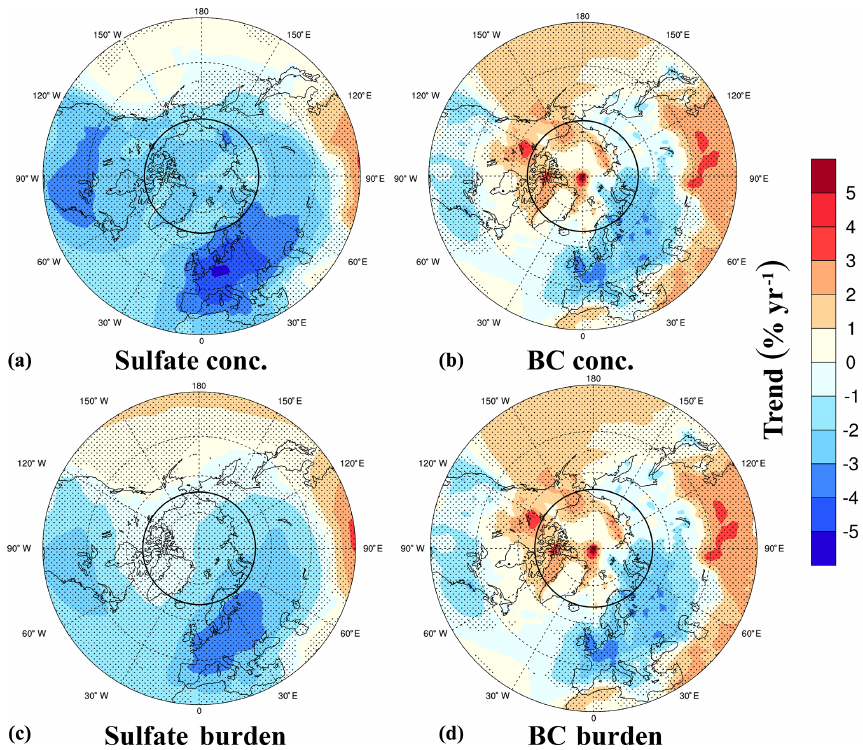
Figure 8. Spatial distribution of linear trends in annual mean sulfate (a, c) and BC (b, d) concentrations (%yr − 1 ) near the surface (a, b) and column burden (c, d) relative to the 39-year averages. The dotted areas indicate statistical significance with 95% confidence based on the F test.